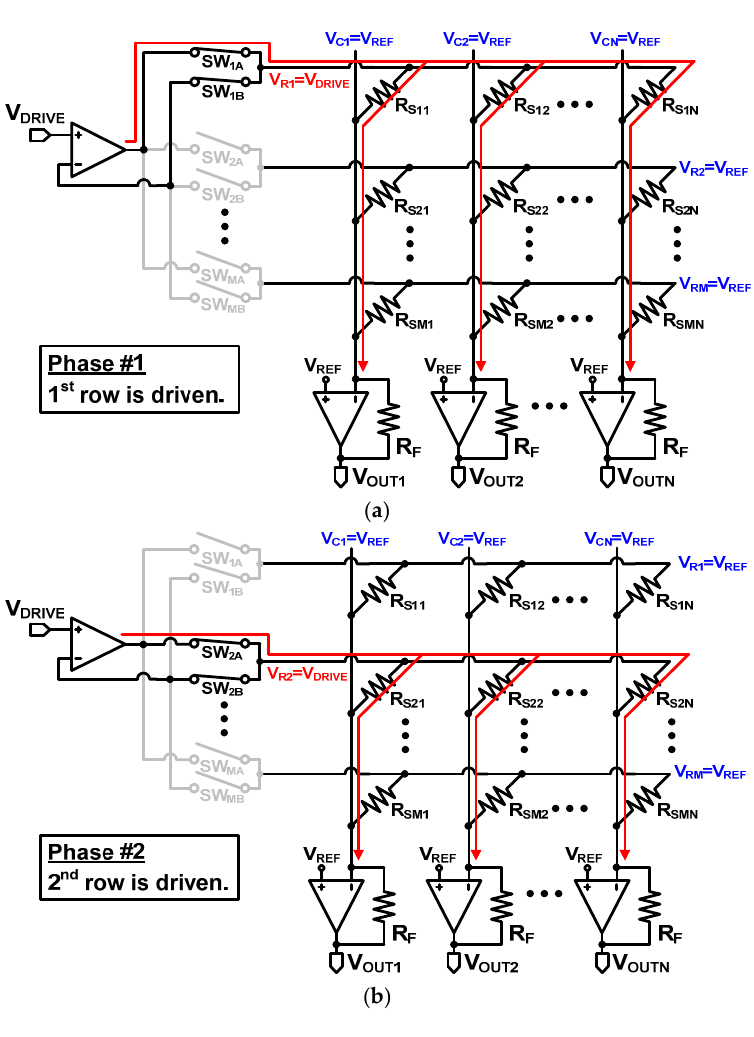
Figure 8. Scanning operation of the proposed row driver Type III. ( a ) 1st and ( b ) 2nd row is driven.